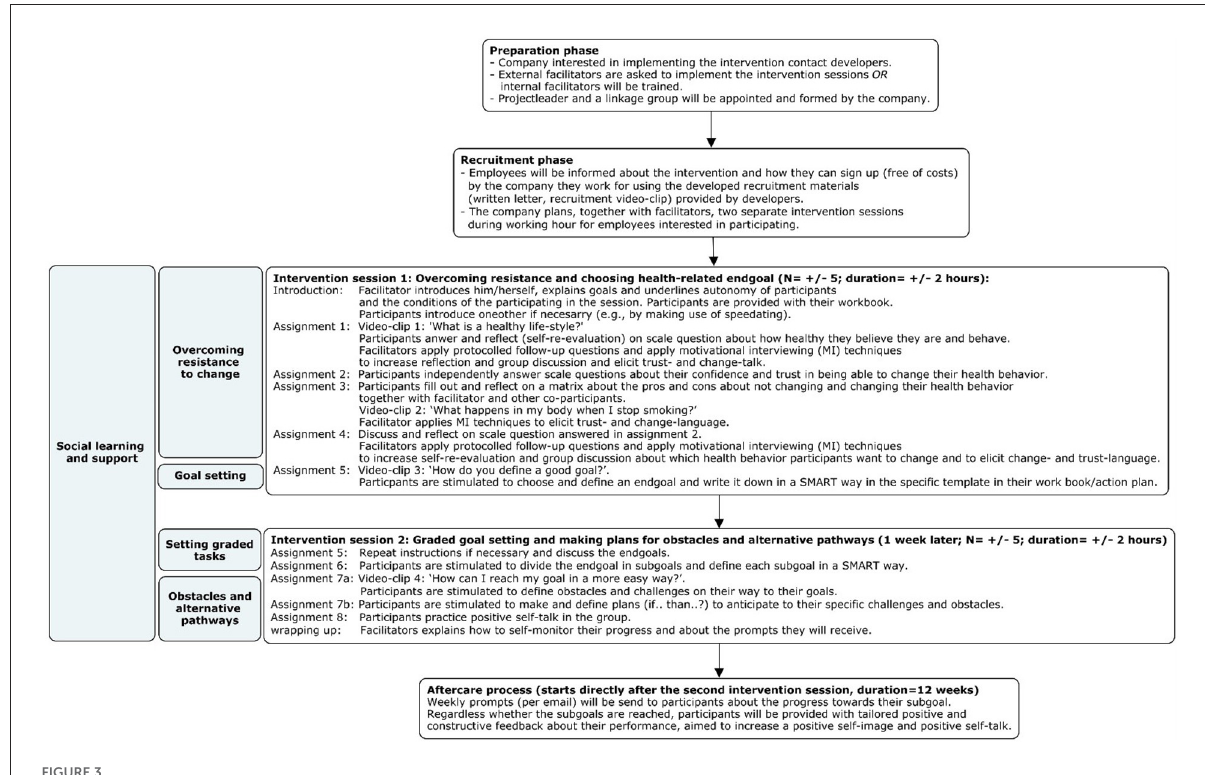
FIGURE3 Overview of intervention